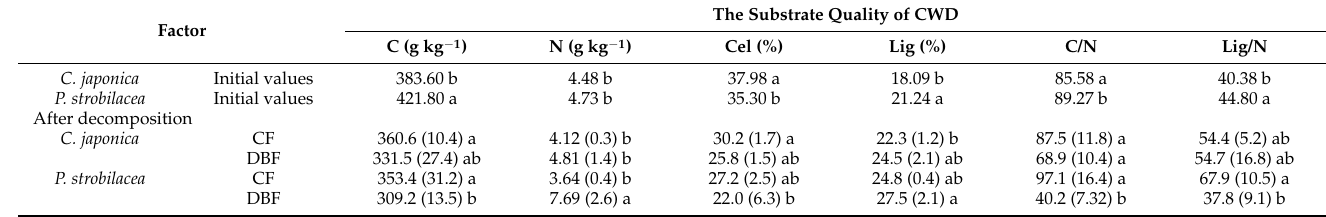
Table 2. The substrate quality of CWD ( n = 3. means ± 1 se) of the two tree types ( C. japonica vs. P. strobilacea ) in the two habitats (CF vs. DBF) after decomposition. Different lowercase letters indicate significant differences ( p < 0.05). CWD: coarse woody debris; CF: coniferous forest; DBF: deciduous broadleaf forest; Cel: cellulose; Lig: